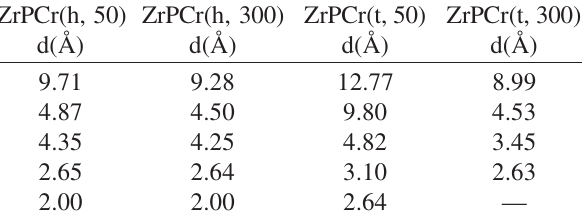
Figure 6. a) UV-Visible spectra of chromium solution; b), ZrP(t, 50); c), ZrP(h, 50); d), ZrP(t, 300); e) chromium hydroxide; f) ZrP(h, 300). Table 2. Interplanar distances of alpha-zirconium phosphate in- tercalated with Cr(III), dried at 50 °C and calcined at 300 °C/2 h.